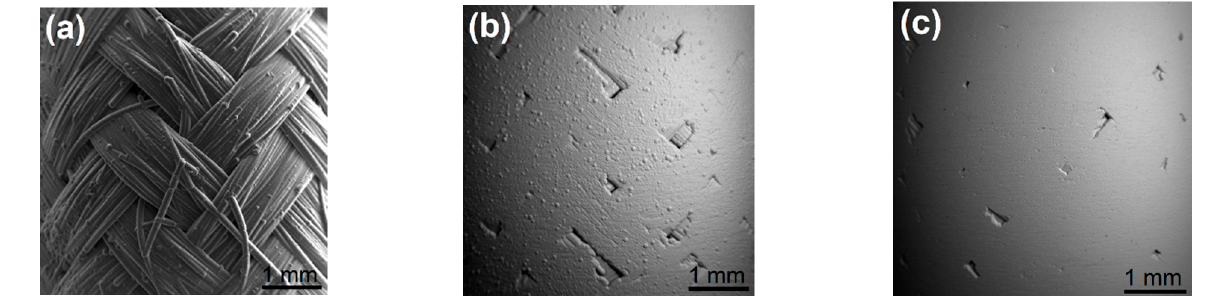
Figure 3. SiCf/SiC sample as received; three levels of surface roughness; ( a ) Ra ~ 50 μ m, ( b ) Ra ~ 10 μ m; ( c ) Ra ~ 1-3 μ m.